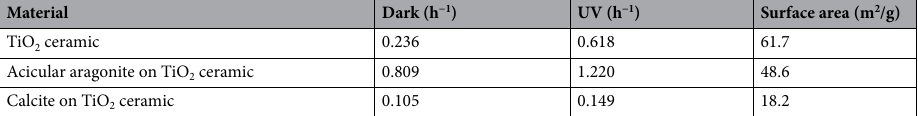
Table 2. Photocatalytic performance of unmodified, aragonite and calcite modified TiO 2 ceramics and their specific surface